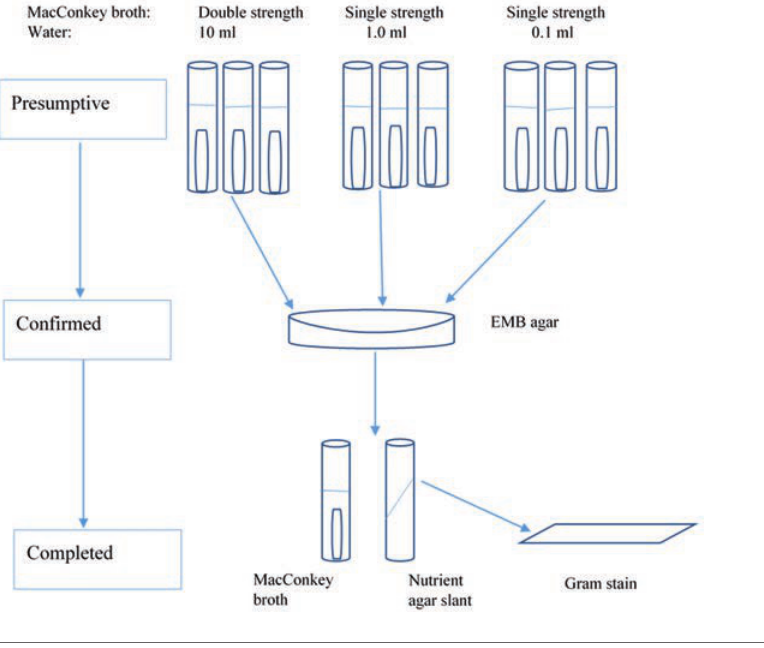
Figure 1. A simple illustration of the multiple-tube fermentation